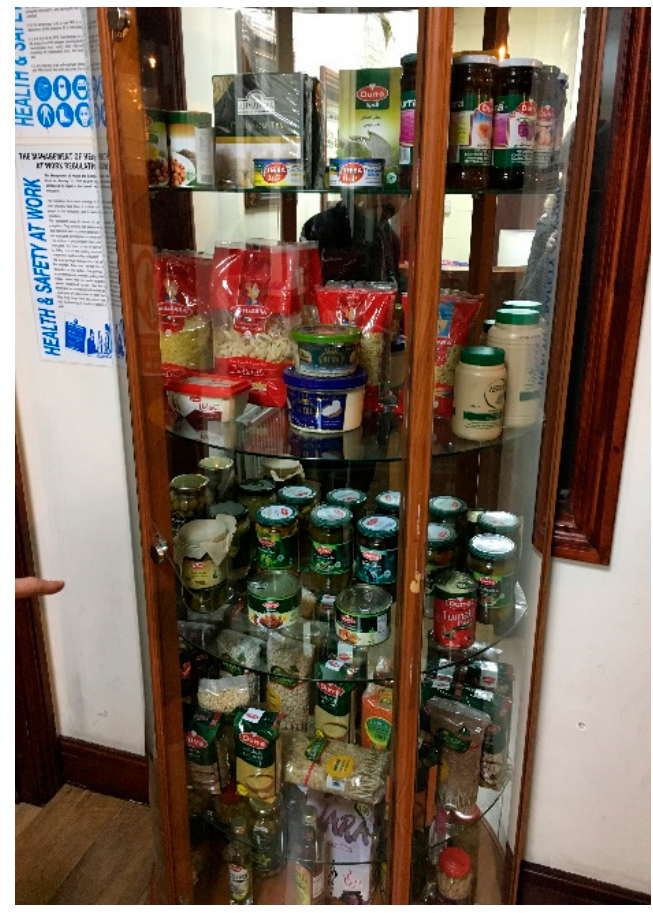
Figure 10. Display cabinet with Syrian goods. Photograph by the author.